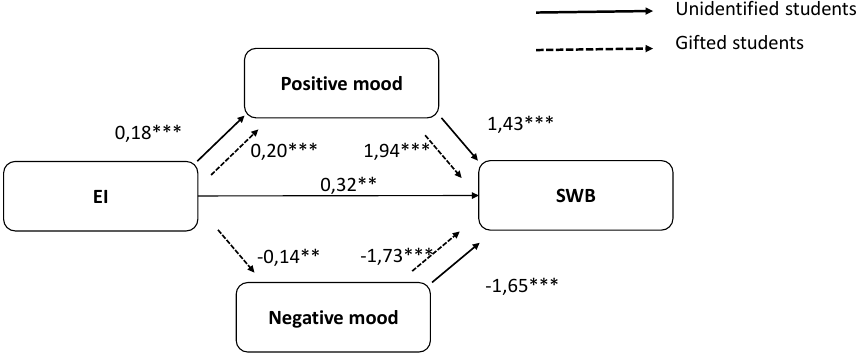
Figure 2. Summary of results of the re-specified model in unidentified children and gifted children.